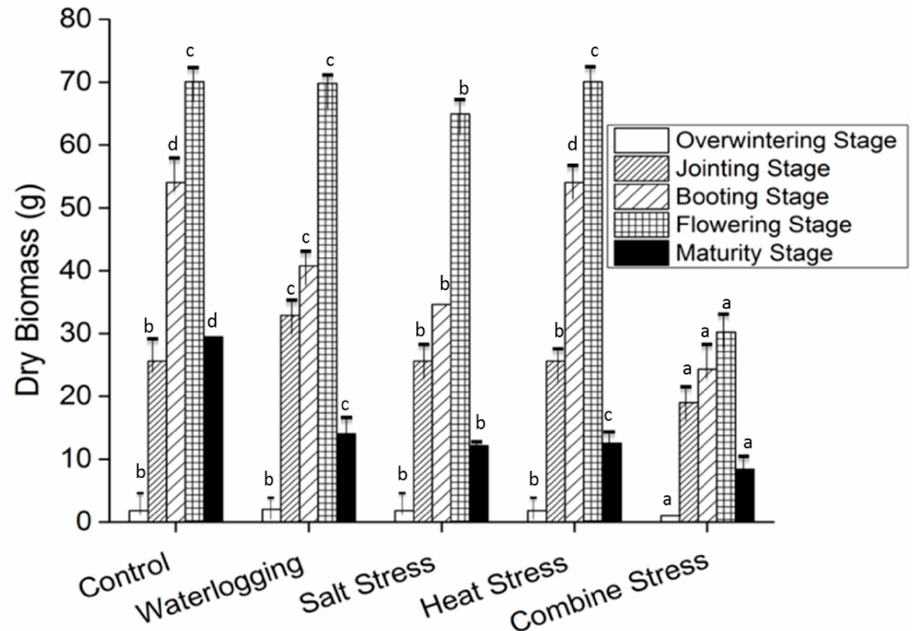
Figure 6. Dry biomass of wheat plants during the five-stage growth of plants grown under different abiotic stresses. Reported values are the means and standard deviations of triplicates for each treatment. Note: sampling date at overwintering stage was 28 December 2020; at jointing stage was 12 March 2021; at booting stage was 30 Mar 2021; at the flowering stage was 17 April 2021; and at maturity stage was 28 May 2021. Lowercase letters show the significant differences among treatments according to one-way ANOVA and DMRT, while the significance level was p ≤ 0.05.